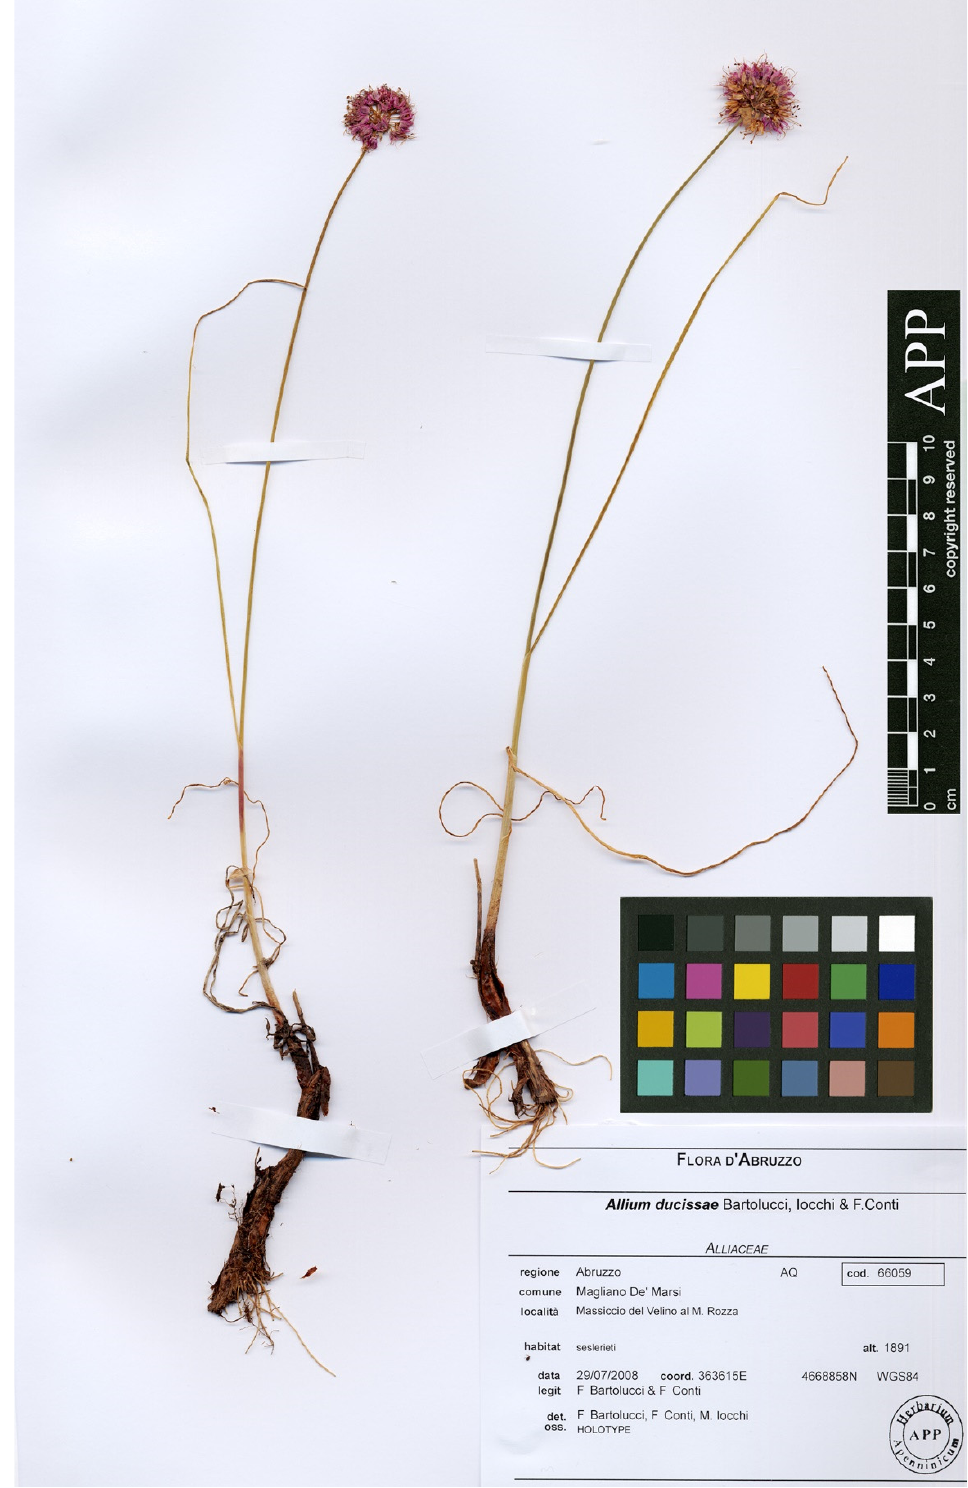
Figure 2. Holotype of Allium ducissae (APP No. 66059, reproduced with permission of the Herbarium, Centro Ricerche Floristiche dell’Appennino, Italy).